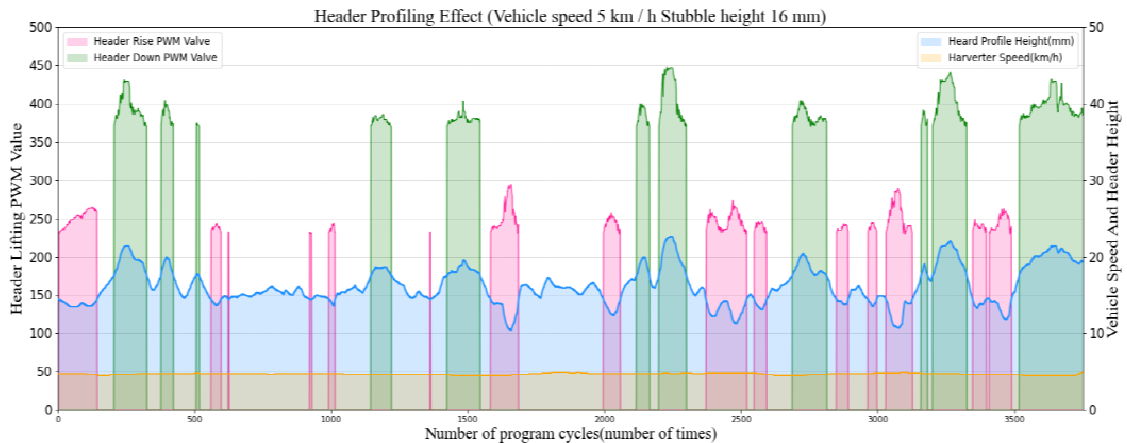
Figure 20. Manual control of harvester header height effect.